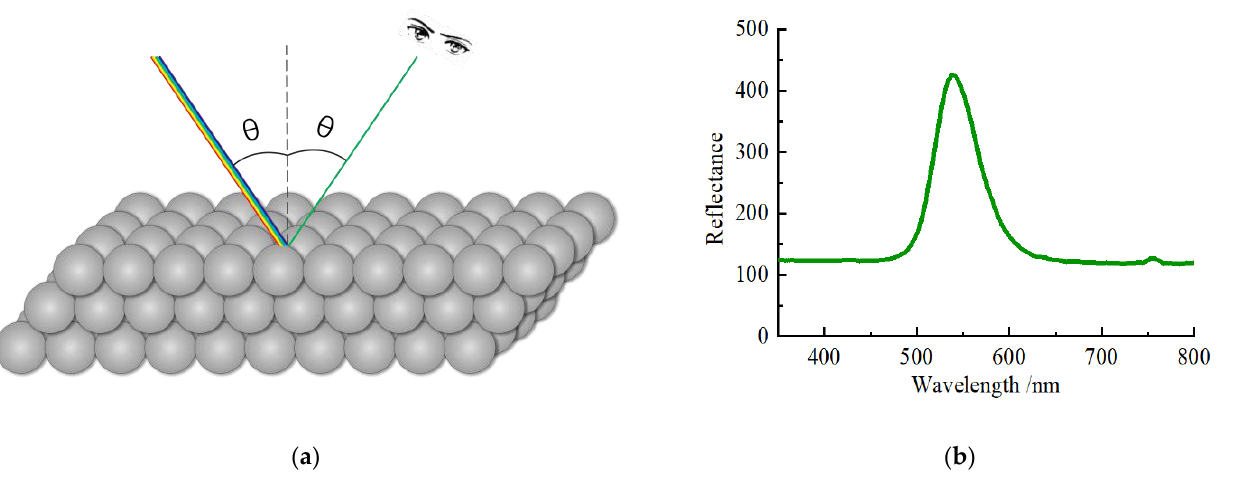
Figure 1. ( a ) Schematic diagram and ( b ) reflection spectrum of photonic crystal generating structural color under incident light irradiation. color under incident light